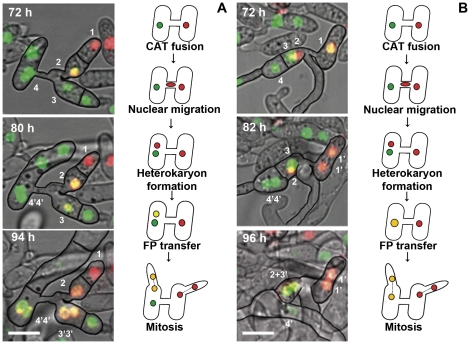
Two mechanisms by which yellow nuclei can be formed in heterokaryotic cells following CAT fusion.Conidia were incubated for 72 h (48 h incubation in water followed by 24 h incubation on PDA). The images of nuclei are shown as projections of z stacks of images with the green and red channels merged. (A) A green nucleus (nucleus 3) eventually turned greenish yellow (80 h), then to yellow when the nucleus underwent mitosis (94 h). Nucleus 4 also turned from green to greenish-yellow (94 h). (B) A red nucleus (nucleus 2) and a green nucleus (nucleus 3) became merged within the same focal plane, suggesting a nuclear fusion event (82 h). Bar = 10 µm.